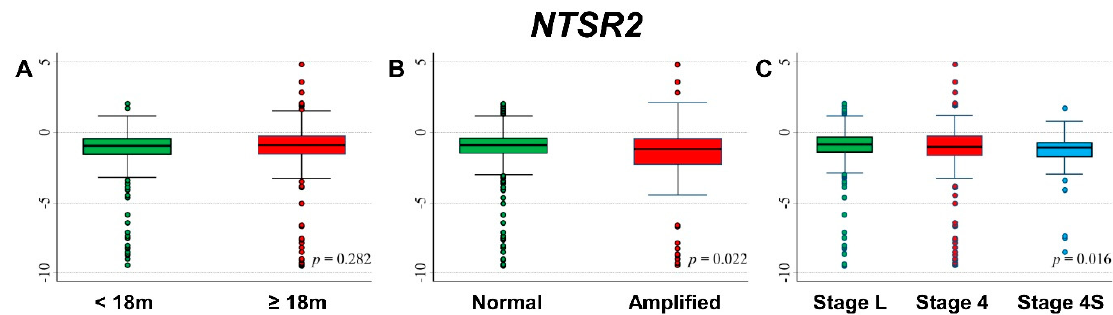
Figure 17. Association between NTSR2 gene expression and the main patient characteristics at diagnosis. ( A ) Age; ( B ) MYCN